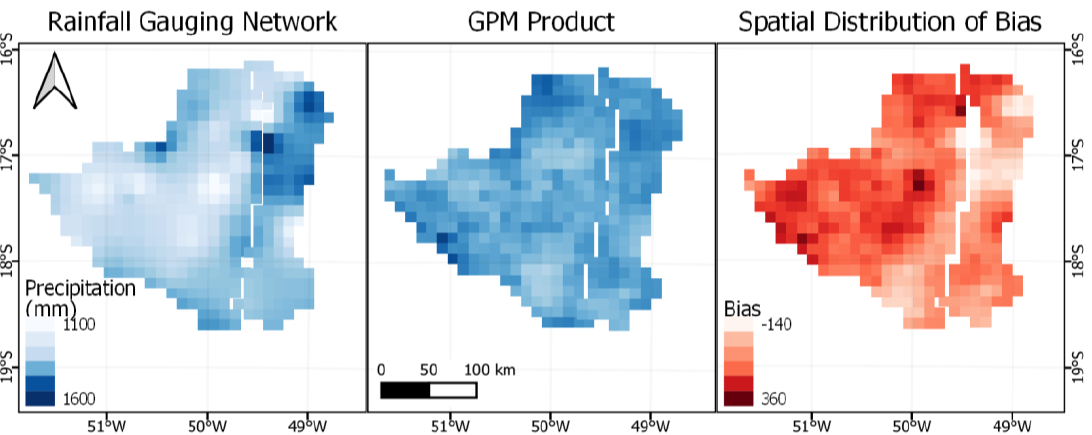
Figure 8. Annual rainfall amounts for the water year of 2017, as obtained from the ground-based rainfall gauging network ( left panel), from the GPM product ( middle panel) and the spatial distribution of bias ( right panel).